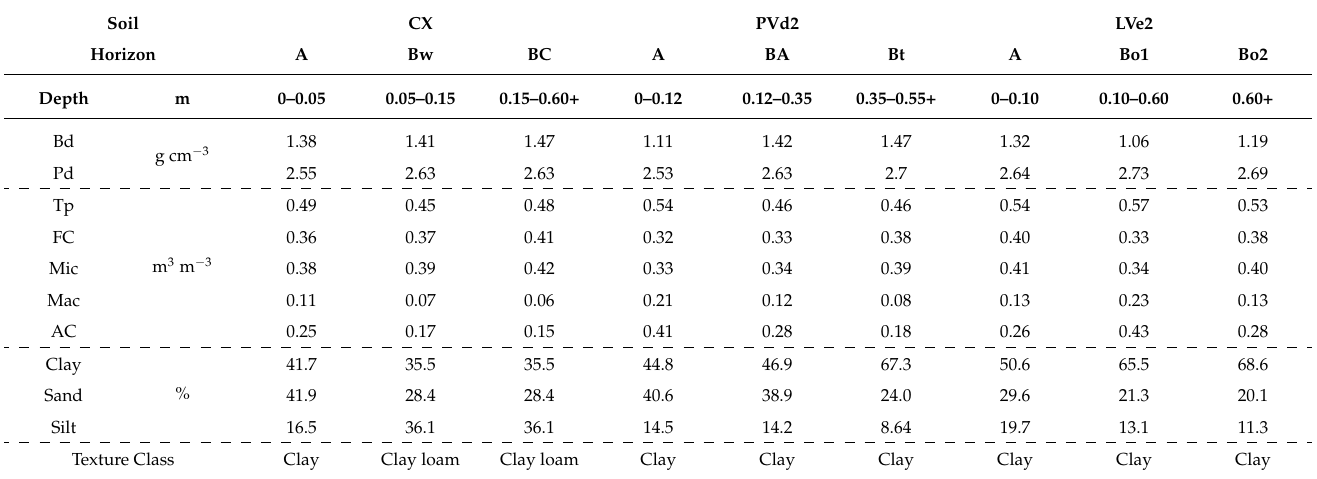
Table 1. Physical characterization of the soils of the experimental